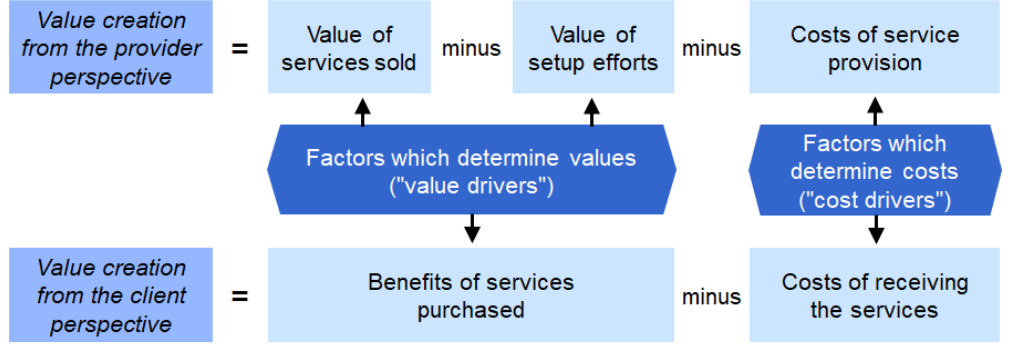
Figure 2. Economic value creation model in the service sector (based on Stauss & Bruhn,